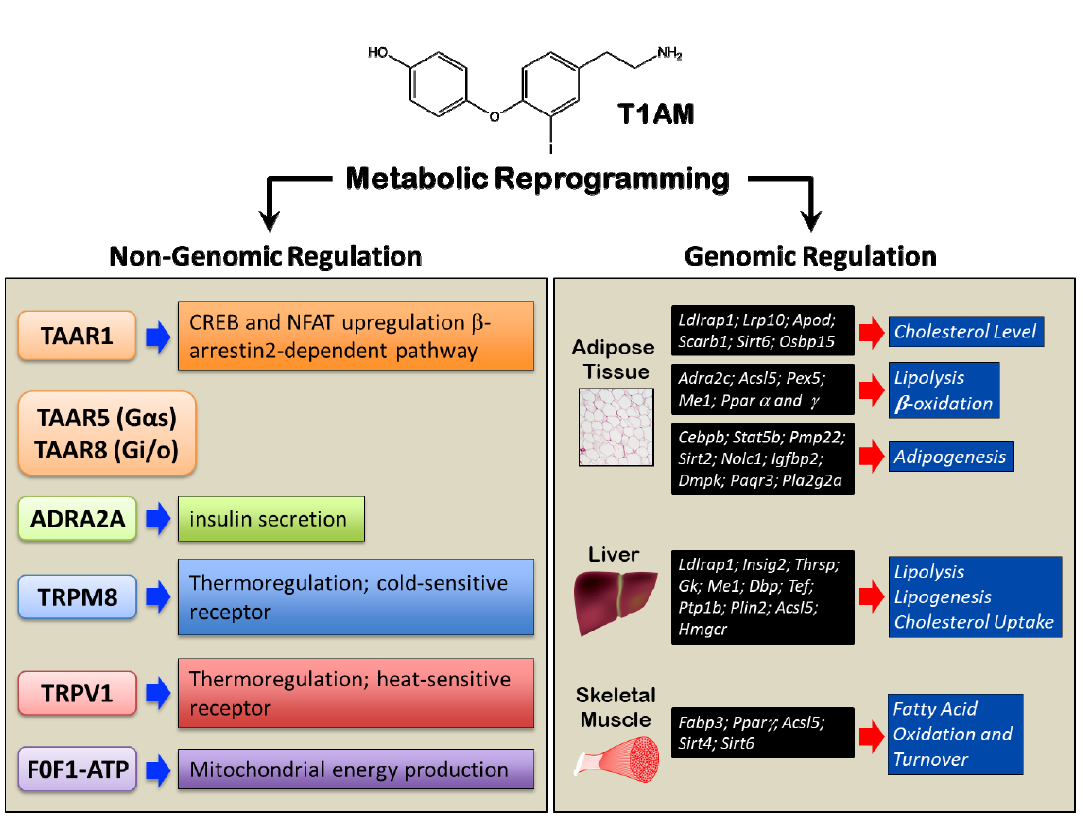
Figure 3. Non-genomic and genomic regulation of metabolism by T1AM.